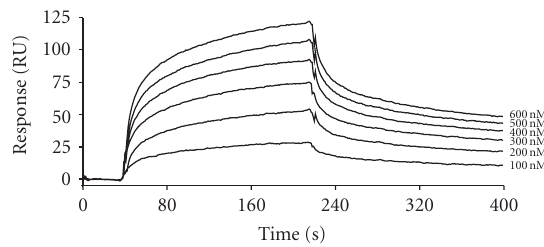
Figure 1: Analysis by surface plasmon resonance spectroscopy of the interaction between C1q and immobilized E-LDL. The E-LDL derivative (14,000 resonance units) was immobilized chemically on the surface of a CM5 sensor chip (GE Healthcare) and allowed to bind to increasing concentrations of soluble C1q (100–600nM). The K D value was determined from the ratio of the dissociation and association rate constants ( k o ff /k on ) (taken from [14], with